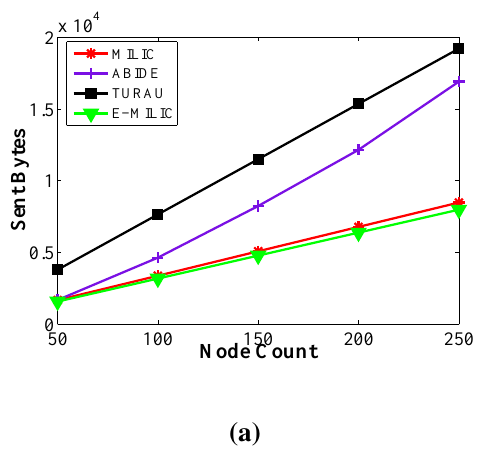
Figure 20. Comparisons between algorithms in terms of sent byte counts and received byte counts for caterpillar-like graphs. ( a ) Sent byte counts against node count; ( b ) received byte counts against node